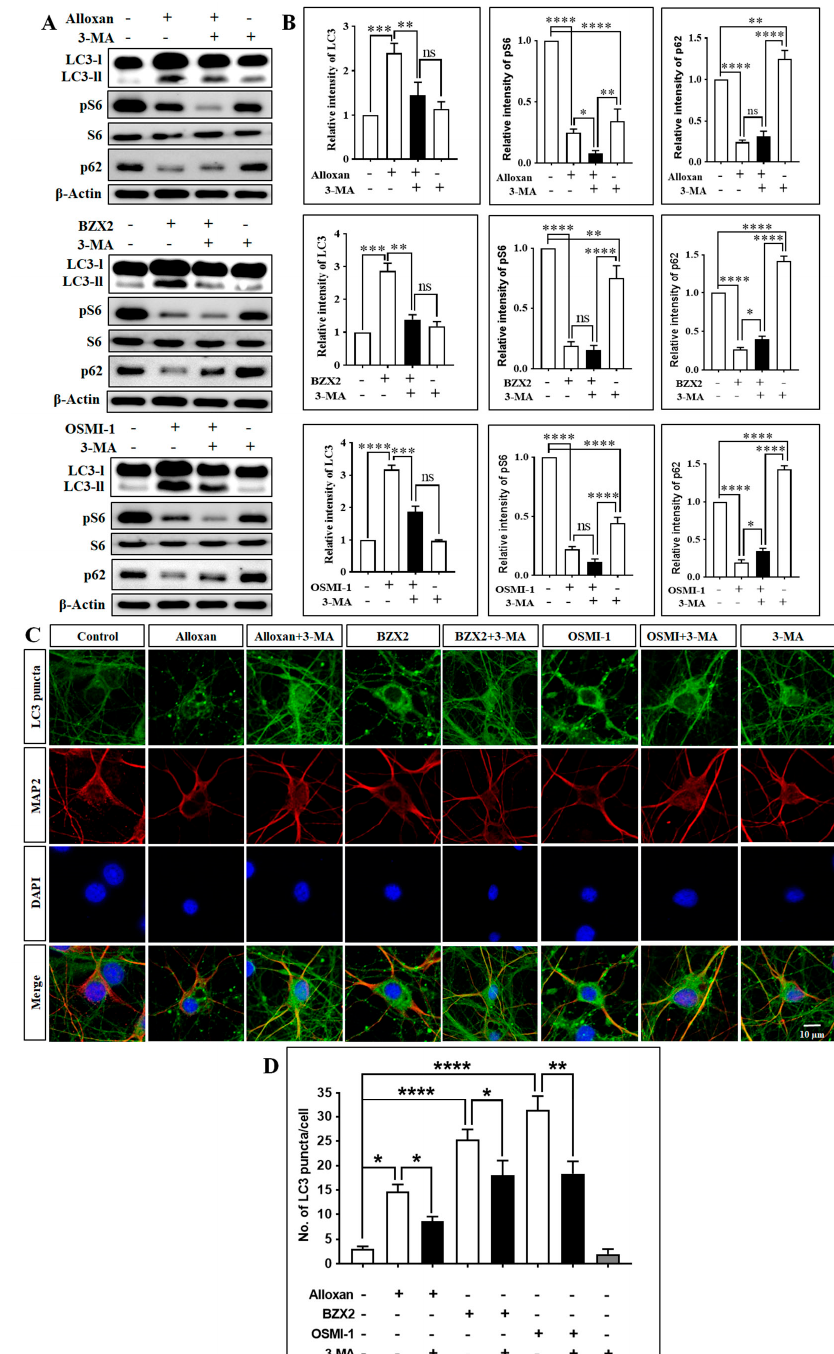
Figure 3. OGT inhibitor-mediated autophagy inhibited by 3-MA in rat cortical neurons. ( A ) Neuronal cells were pre-treated (3 h) with 3-MA (2.5 mM), and subsequently treated with alloxan, BZX2, and OSMI-1 for 24 h. LC3-II/LC3-I, pS6, S6, p62 expressions were determined by immunoblot. ( B ) Band intensities were quantified with Image J, and each protein band intensity was normalized to that of β -actin. All data are presented as mean ± SEM ( n = 3, ns; non-significant, * p < 0.05, ** p < 0.01, *** p < 0.001, **** p < 0.0001). ( C ) Cortical neurons were fixed and stained with Alexa Fluor 488 conjugated-anti-LC3-II antibody (green) and MAP2. Images were acquired with confocal microscopy. ( D ) LC3 puncta formation was measured from at least 3 independent random areas from each slide, as well as a minimum of 5 cells which contained puncta and were counted and calculated (ns = non-significant, * p < 0.05, ** p < 0.01, **** p <